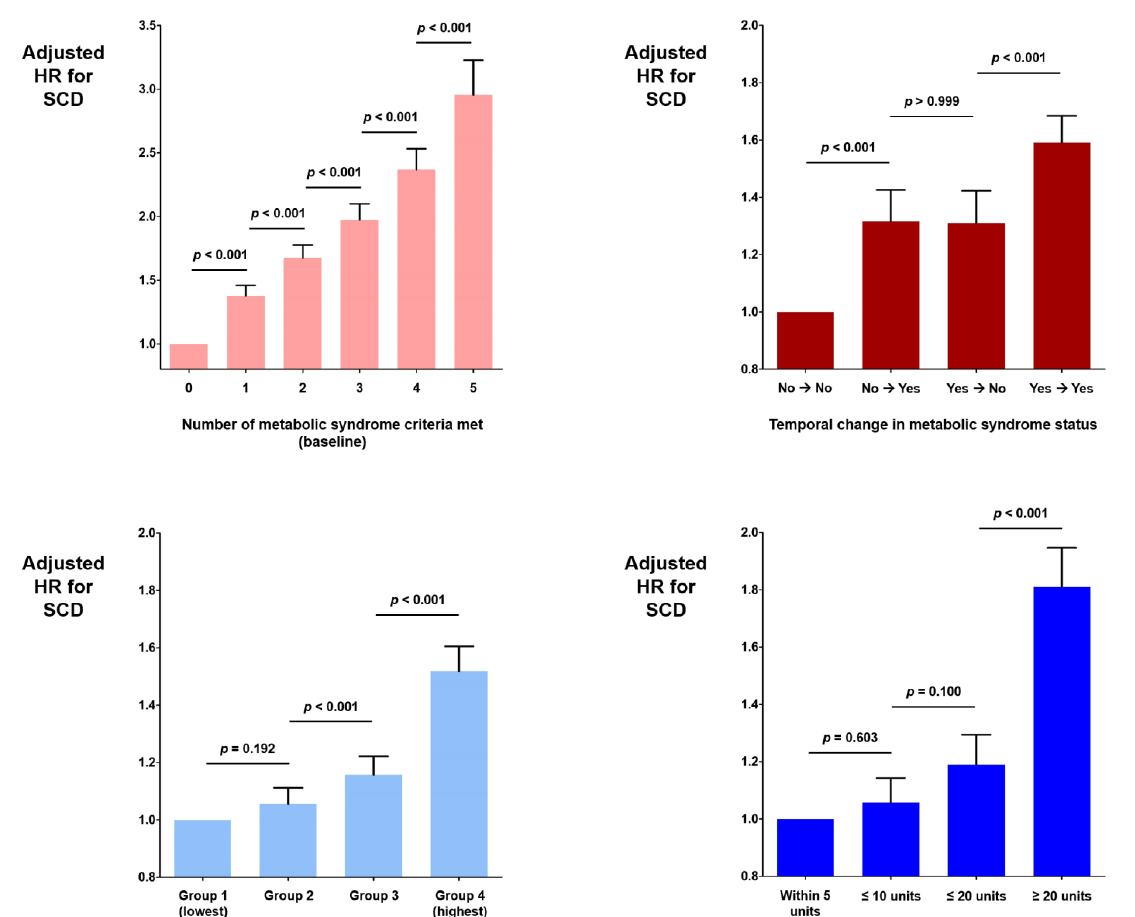
Figure 2. Impact of metabolic syndrome and ɣ -GTP on SCD. The risk of SCD increased linearly according to the number of metabolic syndrome criteria met and serum ɣ -GTP level ( left panels ). Temporal changes in the metabolic syndrome status and serum level of ɣ -GTP significantly influ- enced the SCD risk ( right panels ). The whiskers indicate 95% confidence intervals. p -values are pre- sented with Bonferroni correction. ɣ -GTP, gamma-glutamyl transferase; HR, hazard ratio; SCD, sud- den cardiac death.